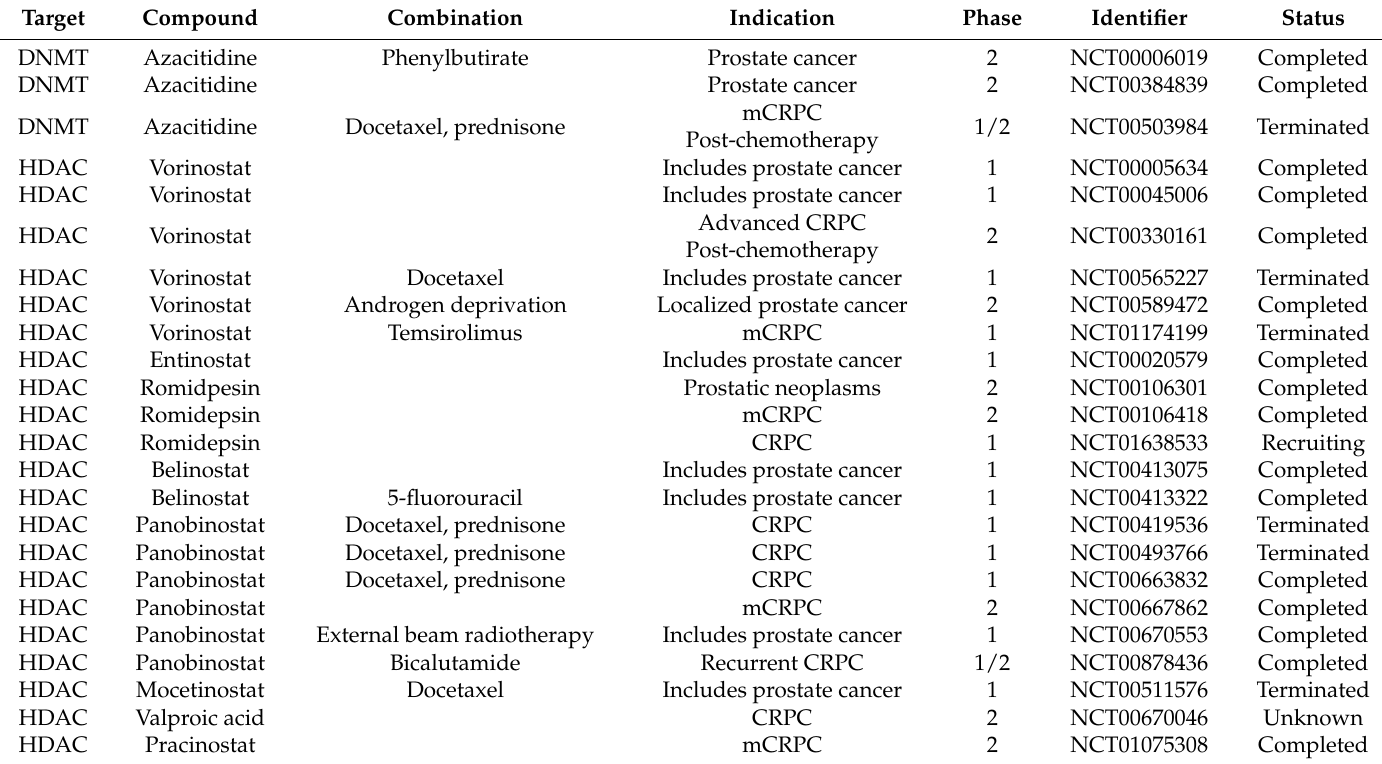
Table 1. Clinical studies in prostate cancer, including castration-resistant prostate cancer (CRPC) and metastatic CRPC (mCRPC), with drugs addressing DNA methyltransferases (DNMTs) or histone deacetylases (HDACs). Source: